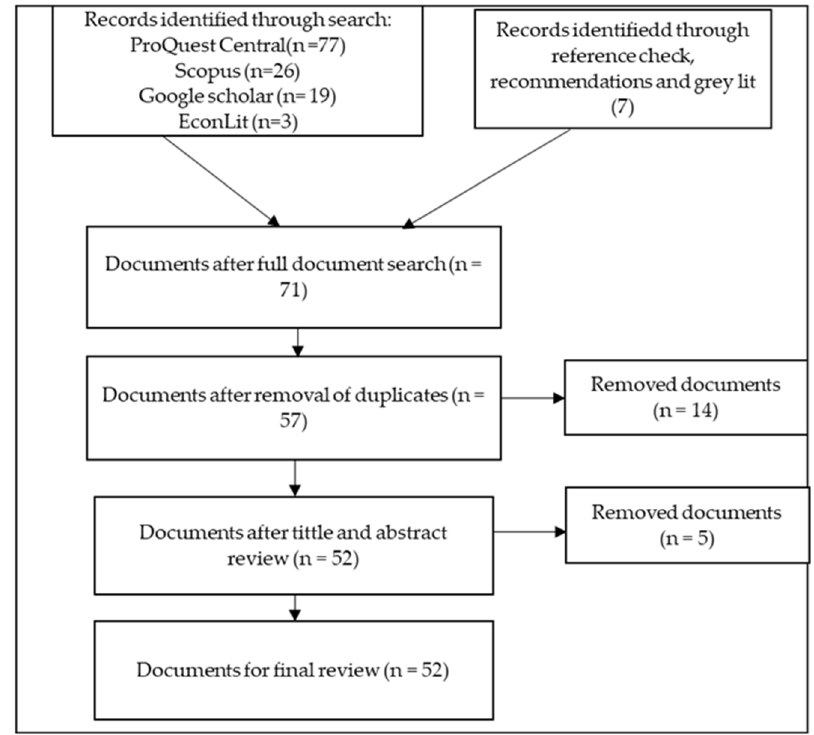
Figure 1. Literature search method using PRISMA framework.